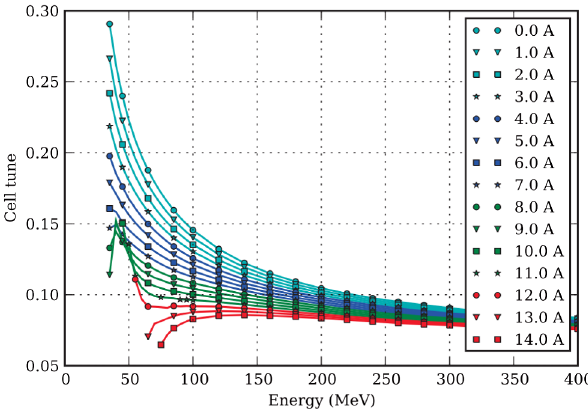
FIG. 4. Cell tune as a function of energy and peak current for 10 mm mrad beam